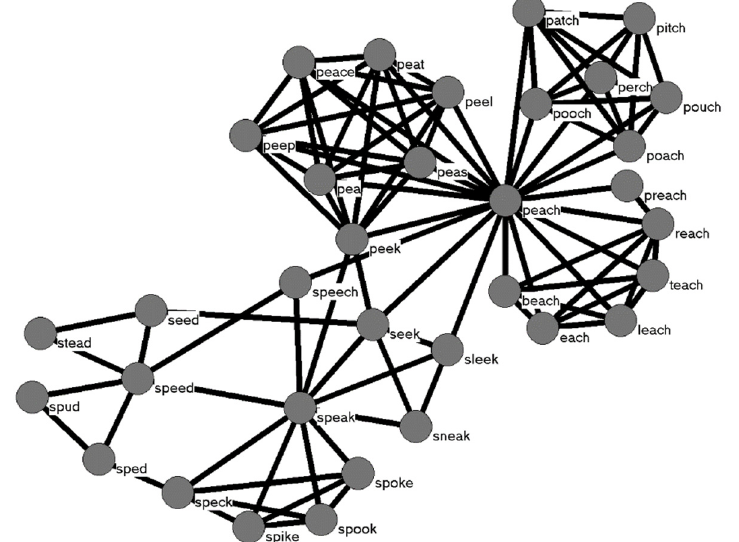
Figure 1. An example of a phonological network where nodes represent words in the mental lexicon, and edges connect words that are phonologically similar to each other (based on the addition, deletion, or substitution of a phoneme in one word to form another word). Phonological similarity can be defined in other ways as well. This network represents the 2-hop neighborhood of the word speech; a 2-hop network contains the neighbors of a word, and the neighbors of the neighbors.